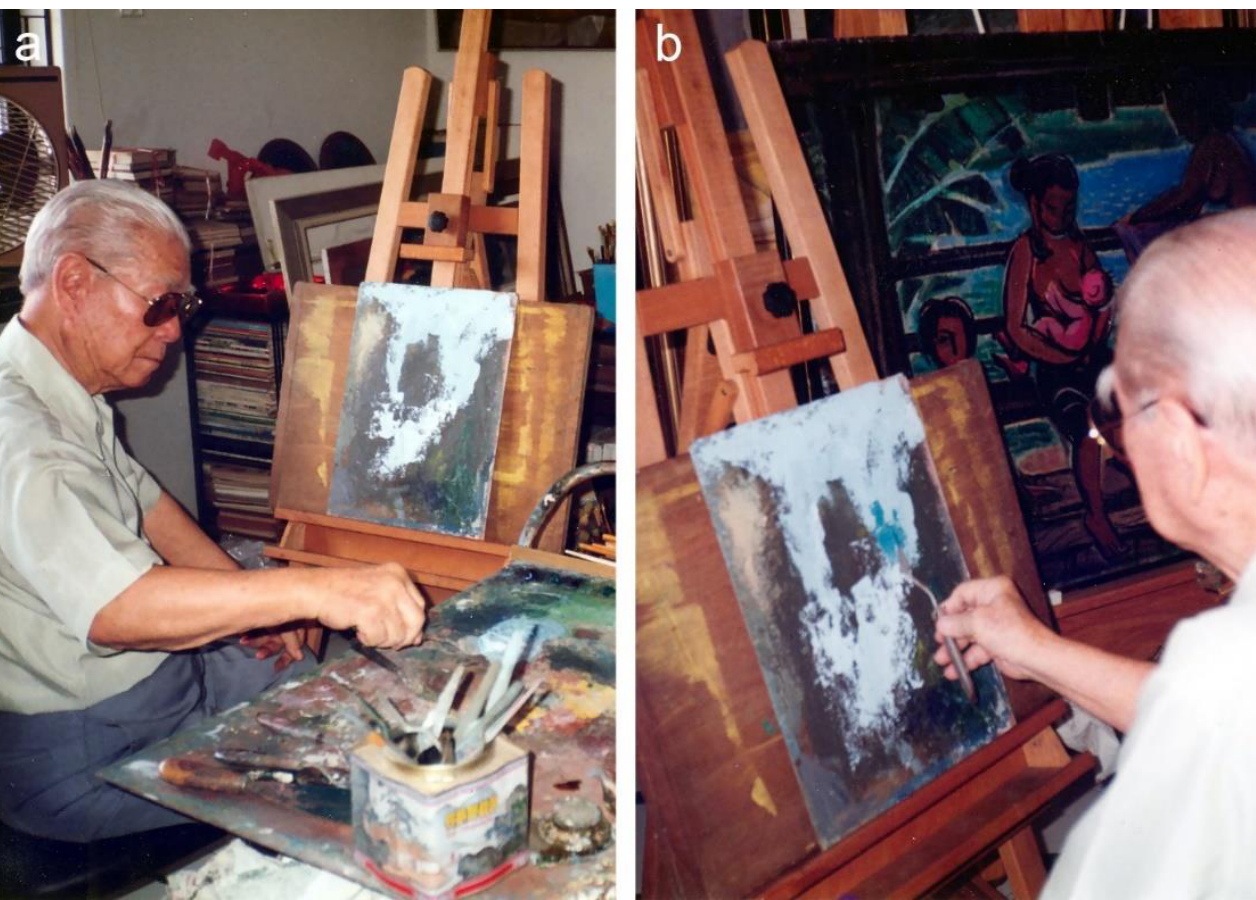
Figure 6. Archival photographs of Liu Kang from the 1990s showing the artist at work. The photo- graphs show the initial underpaint of the sky area conducted over an earlier composition ( a ) and subsequent application of colour for the depiction of vegetation or distant hilltops ( b ). Liu Kang family collection. Images courtesy of the Liu family.